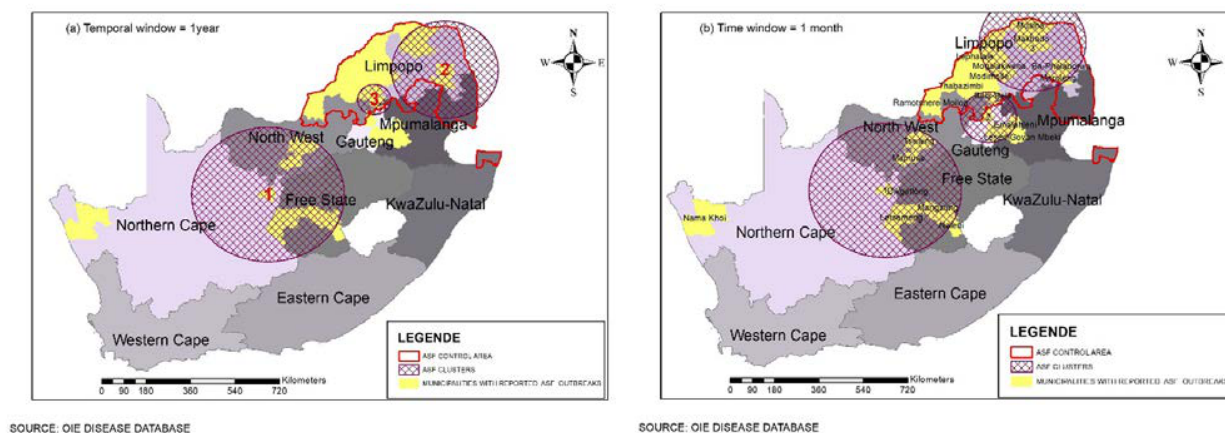
Figure 7: Local spatiotemporal clusters of ASF outbreaks in South Africa using SaTScan